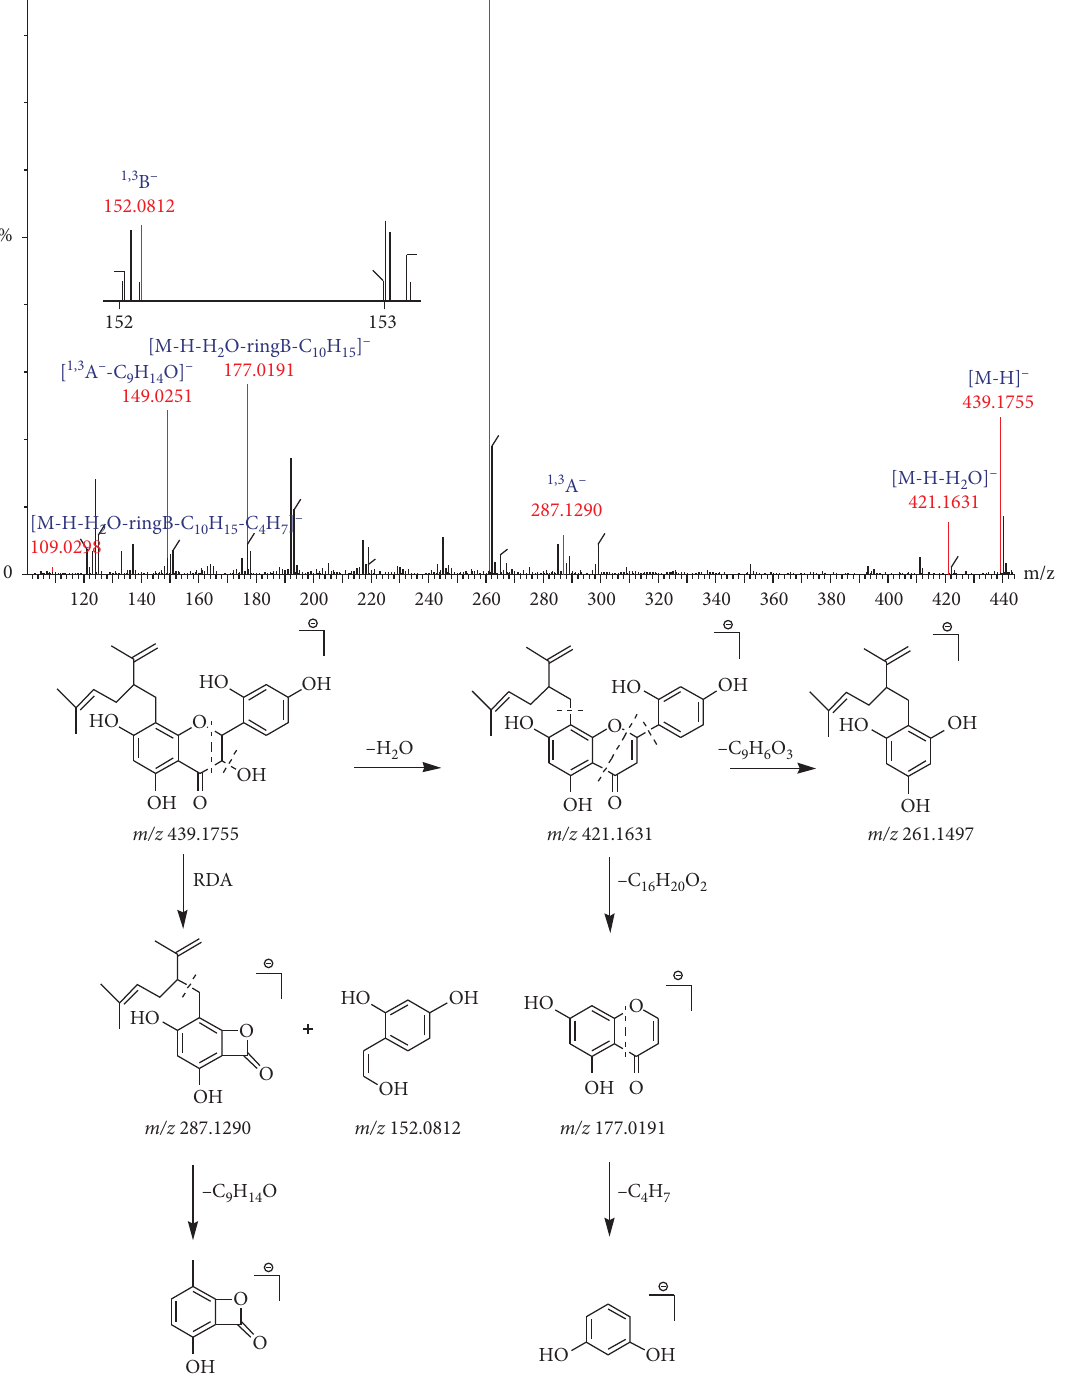
Figure 6: The fragmentation process of kushenol X in the negative ion